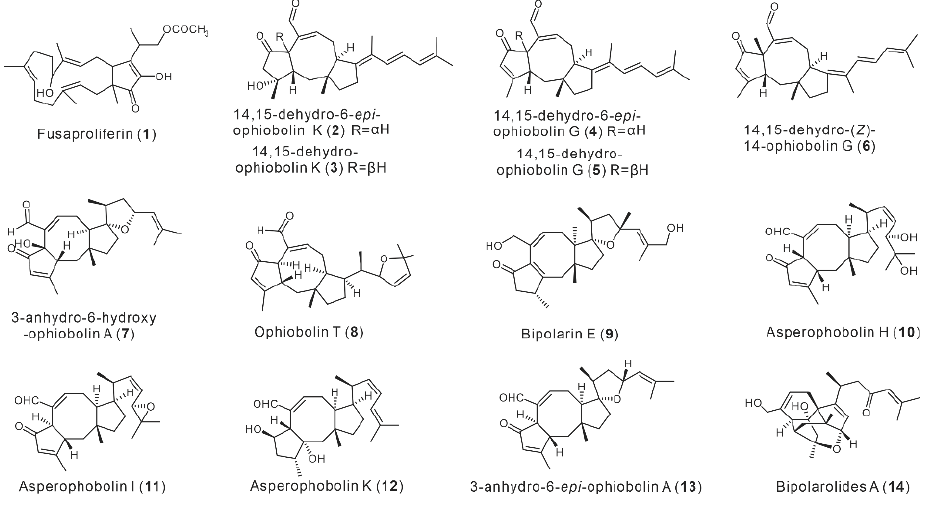
Figure 1. Representative natural sesterterpenes of fungi.